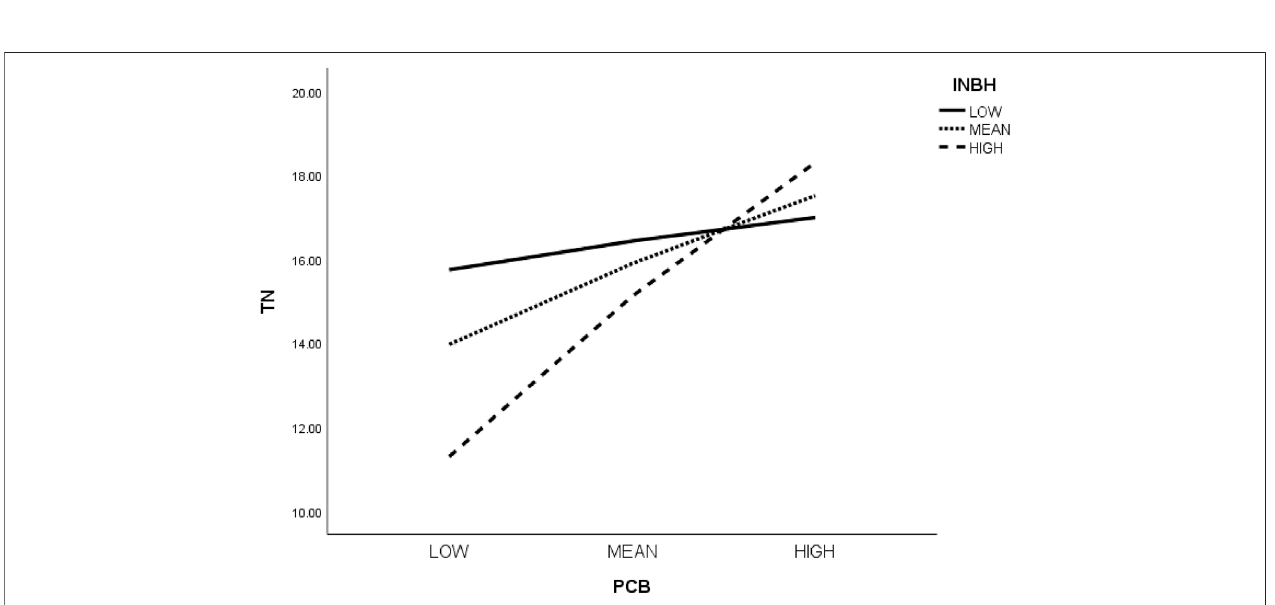
FIGURE 4 | moderating role of organizational climate (engaged behaviour) in the psychological contract breach and turnover intentions relations.